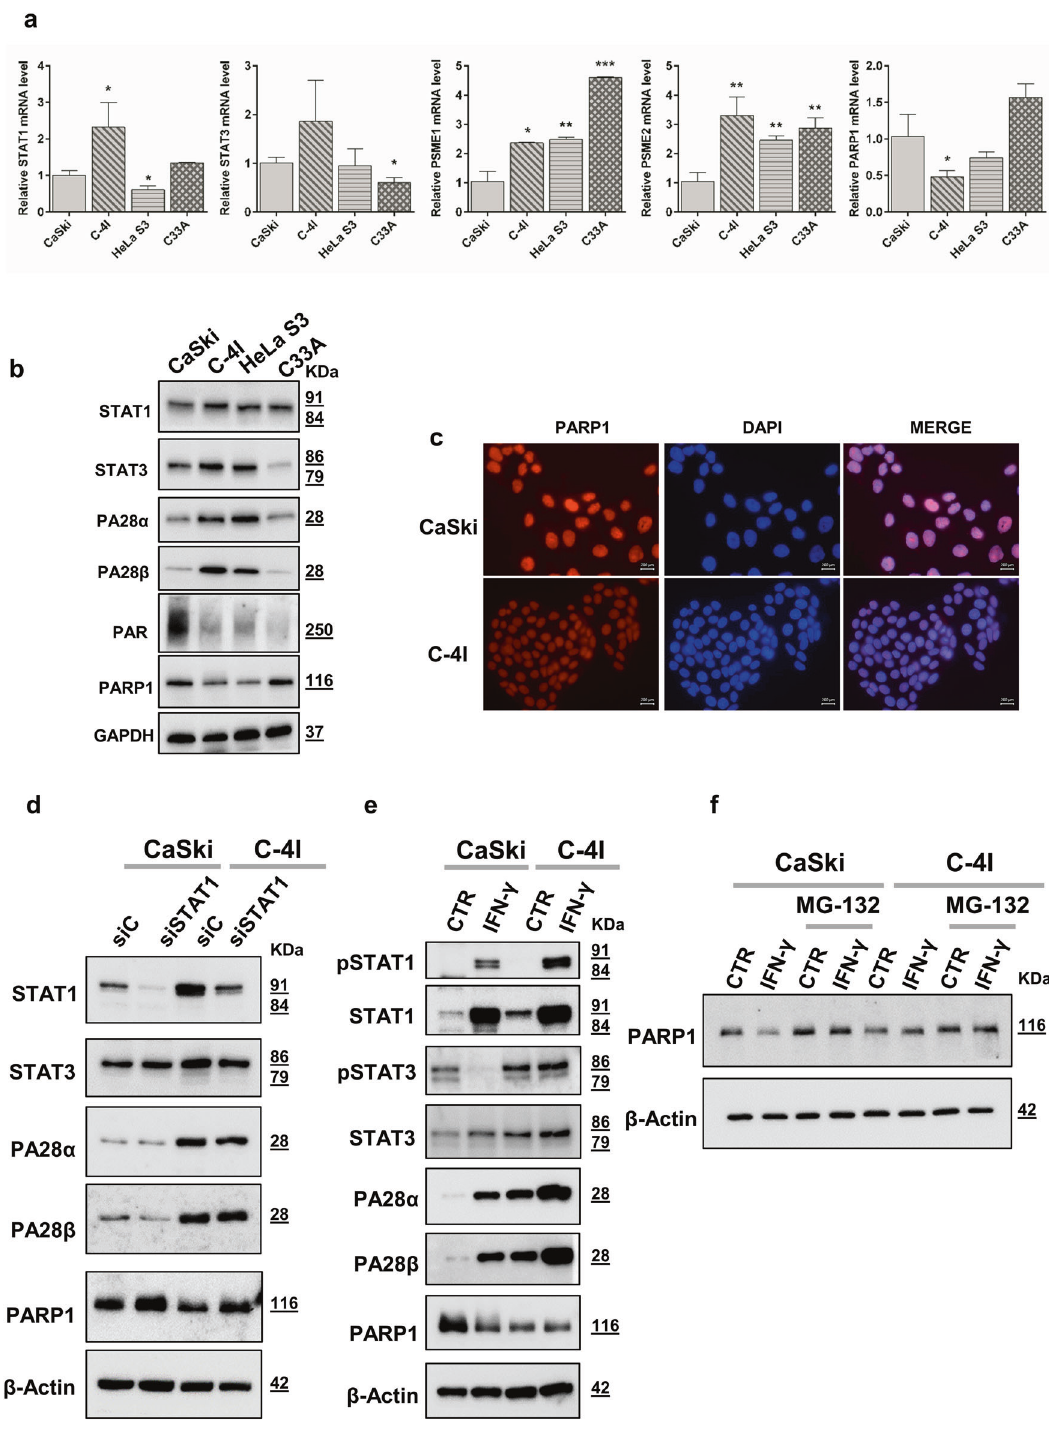
Fig. 1 STAT1-mediated control of PARP1 levels in cervical cancer models. a Relative mRNA expression level of STAT1, STAT3, PSME1, PSME2, and PARP1 was evaluated by RT-qPCR in CaSki, C-4I, HeLa S3, and C33A cells. Samples were normalized to the mean of two housekeeping genes, GAPDH and PGK1. For each mRNA, results are presented as fold change compared to CaSki cells (mean ± SD, n = 3). Statistical signi fi cances have been evaluated through an unpaired t -test. * P < 0.05, ** P < 0.01, *** P < 0.001 respect to CaSki cells. b Representative Western blot analysis of STAT1, STAT3, PA28 α , PA28 β , PARP1 proteins in CaSki, C-4I, HeLa S3, and C33A cells. GAPDH was used as a control. c Representative pictures showing immunolocalization of PARP1 in CaSki and C-4I cells (magni fi cation 63x). d , e Representative Western blot of STAT1, STAT3, PA28 α , PA28 β , PARP1 proteins in CaSki, and C-4I cells. Cells were harvested 48 h following STAT1 silencing ( d ) or 10 ng/ml of IFN- γ treatment ( e ) and whole-cell lysates (10 μ g) were loaded into SDS-PAGE, followed by Western blot with speci fi c antibodies. β -Actin was used as a loading control. f CaSki and C-4I cells were treated with 10 ng/ml IFN- γ for 24 h and then added MG-132 (0.5 µM) for an additional 24 h. Cells were harvested and whole-cell lysates (10 μ g) were loaded into SDS-PAGE, followed by Western blot with speci fi c antibodies. β -Actin was used as a loading control. siC siRNA control, siSTAT1 siRNA targeted to STAT1, CTR untreated, IFN- γ interferon- γ . Data were representative of at least three